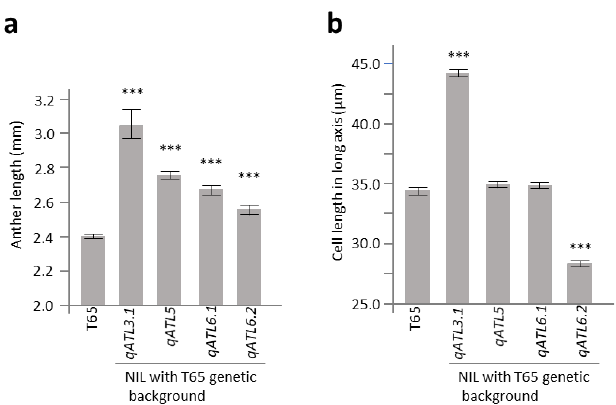
Figure 5. Characterization of QTLs using nearly isogenic lines (NIL) carrying W1508 chromosomal segments around QTL regions detected in this study. ( a ) Anther length (mm) in the NILs. Mean ± SE, n = 3; ( b ) cell length ( µ m) in the long axis of anthers in the NILs. * and ** represent significant di ff erences in Dunnett’s multiple comparisons to T65 control at 5% and 1% levels, respectively. The numbers of observed cells were 1460, 997, 953, 879, and 1033 in qATL3.1 NIL, qATL5 NIL, qATL6.1 NIL, qATL6.2 NIL, and T65